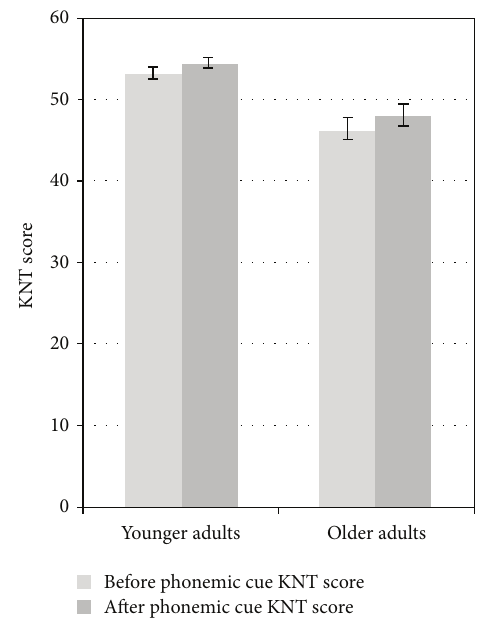
Figure 3: Mean KNT scores before and after phonemic